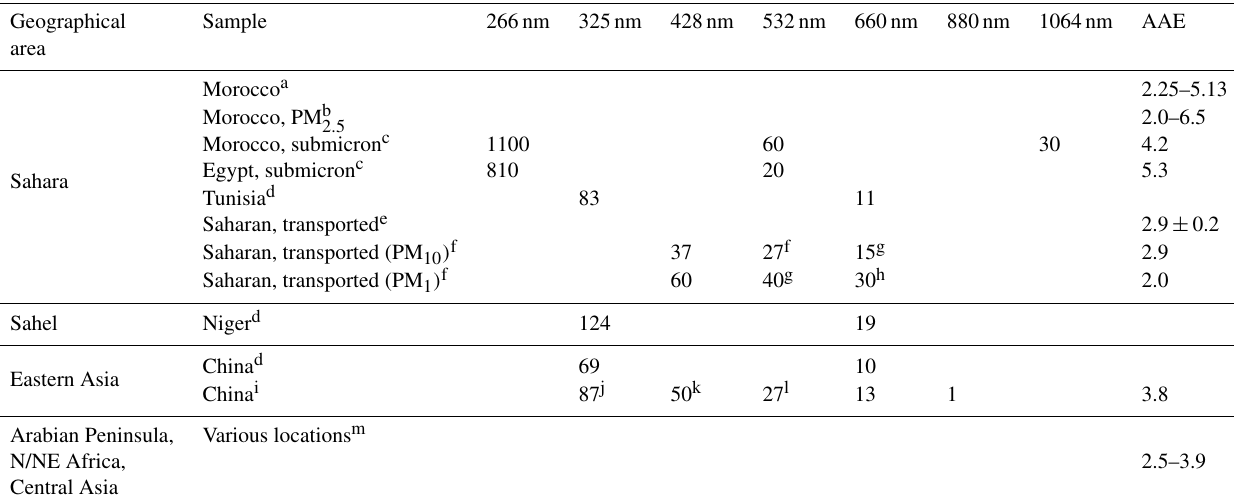
Table 5. Mass absorption efficiency (MAE, 10 − 3 m 2 g − 1 ) and Ångström absorption exponent (AAE) from the literature data discussed in the